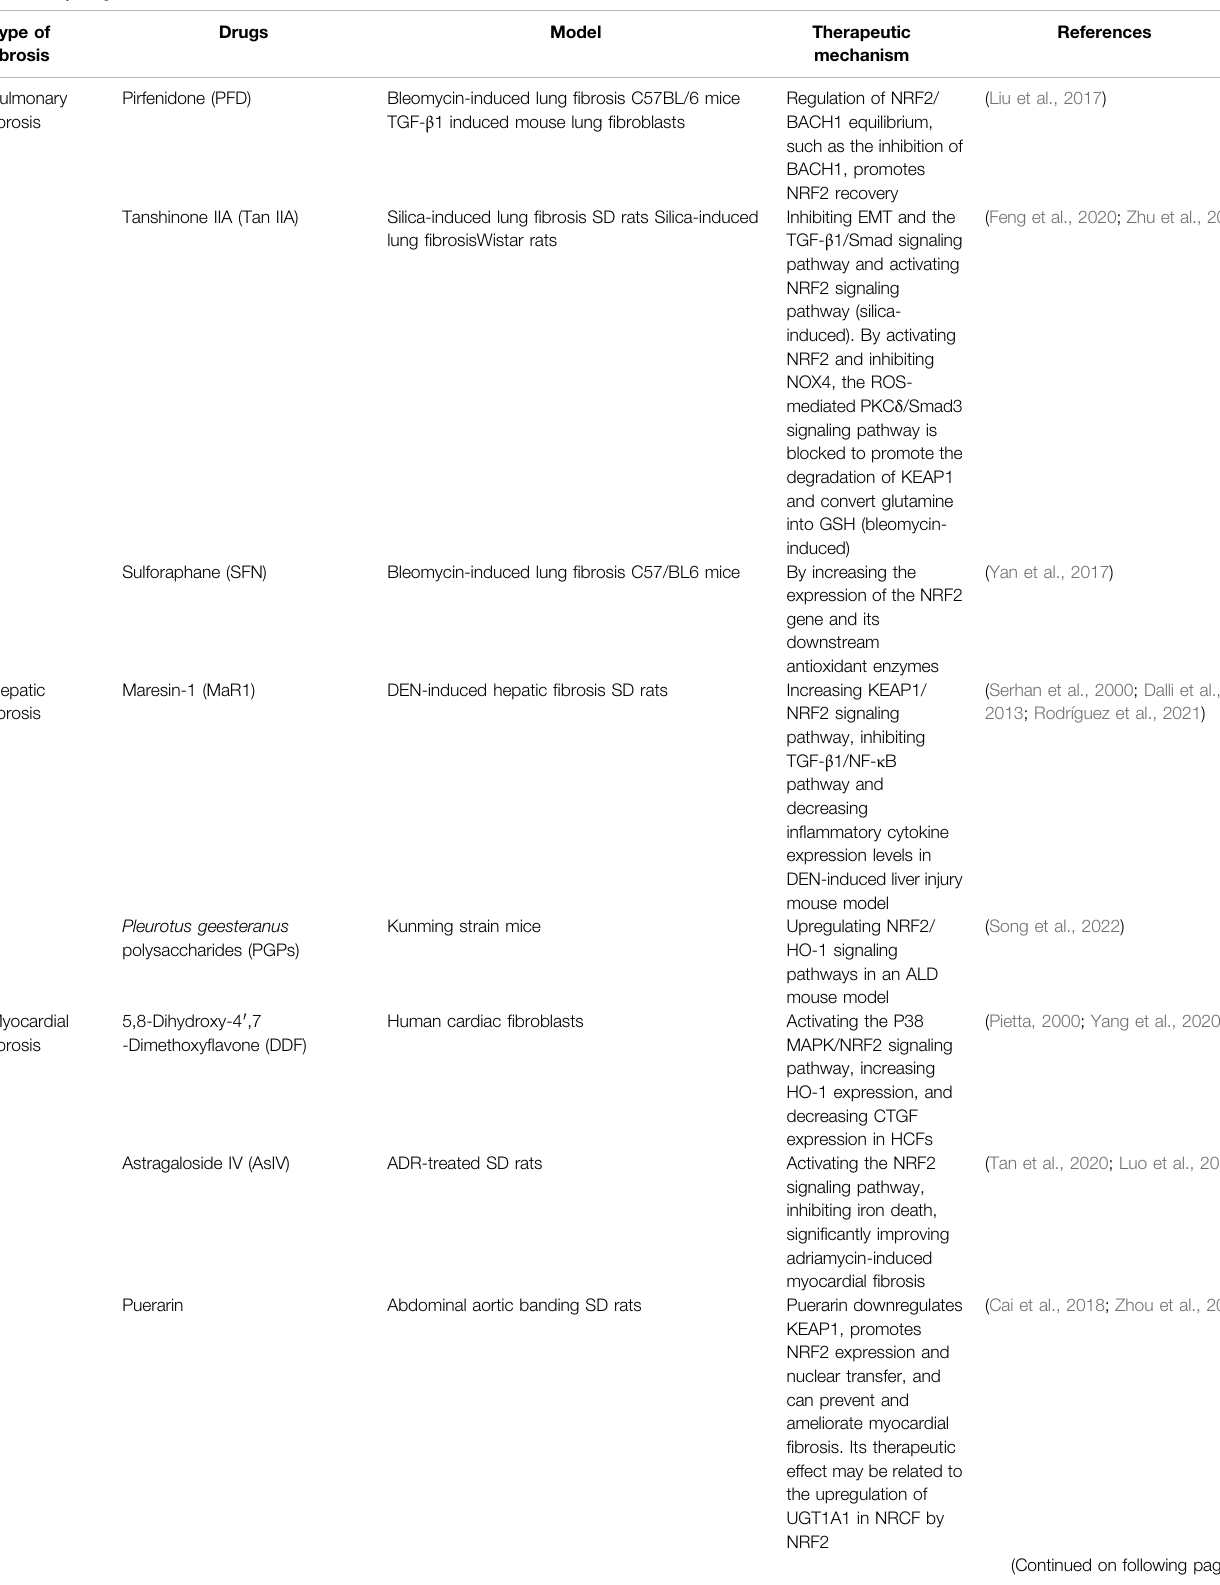
TABLE 1 | Drugs Related to NRF2 in Fibrotic